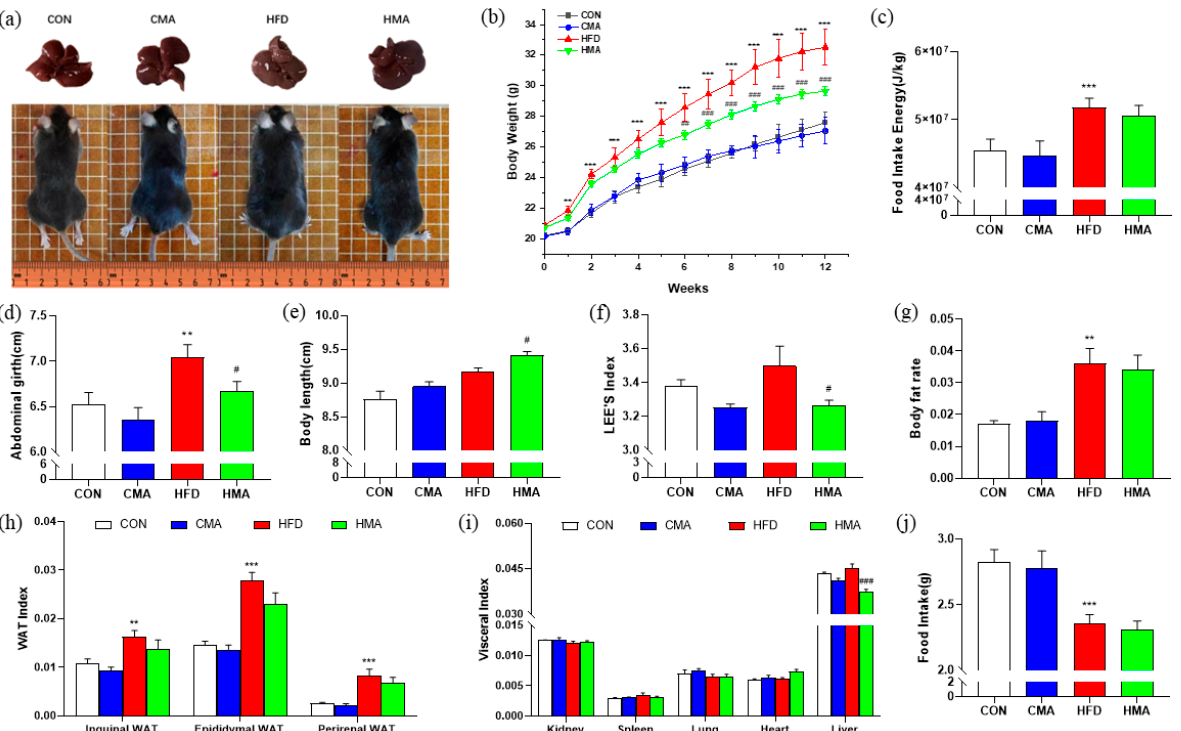
Figure 1. Effects of MA on body weight, energy intake, body fat rate and organ index in mice. ( a ) Mouse appearance and liver. ( b ) Body weight. ( c ) Food intake energy. ( d ) Abdominal girth. ( e ) Body length. ( f ) Lee’s index. ( g ) Body fat rate. ( h ) WAT index. ( i ) Visceral index. ( j ) Food intake. C57BL/6J mice were divided into four groups and fed a basal diet (CON, 10% fat) or high-fat diet (HFD, 60% fat) (CON + 0.03 mL/10 g MA (CMA) and HFD + 0.03 mL/10 g MA (HMA)) for 12 weeks. Data are expressed as mean ± SEM (n = 10). Differences between the CON group and the CMA and HFD groups are indicated by *. *** p < 0.001, ** p < 0.01. Differences between the HFD group and the HMA group are expressed by # . ### p < 0.001, ## p < 0.01, # p < 0.05.